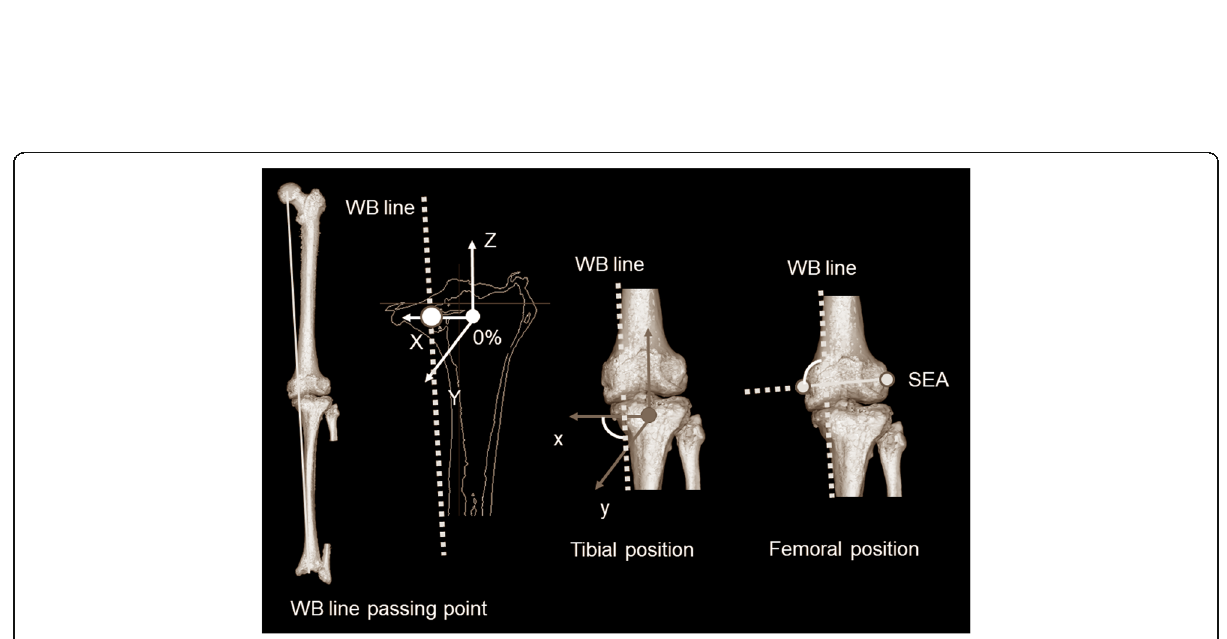
Fig. 5 Schematic diagram showing the WB line passing point, tibial position, and femoral position. Regarding WB line passing point, WB line was defined as the line connecting the femoral head with the center of the ankle joint in a 3D space. WB line passing point was the location of the WB line on the xy plane in the tibial coordinate system. The WB line in the tibial coordinate system was described by percent indication (0% = origin in the tibial coordinate system, + 100%= medial-most point in MCT, and ≥ 100% = passing point outside from MCT). The tibial position was defined as the angle between the WB line and the x -axis in the tibial coordinate system. The femoral position was defined as the angle between the WB line and the surgical epicondylar axis in the tibial coordinate